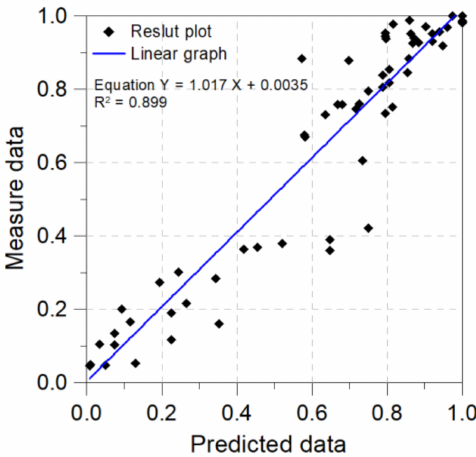
Figure 12. Correlations between simulated results and predicted results by Equation